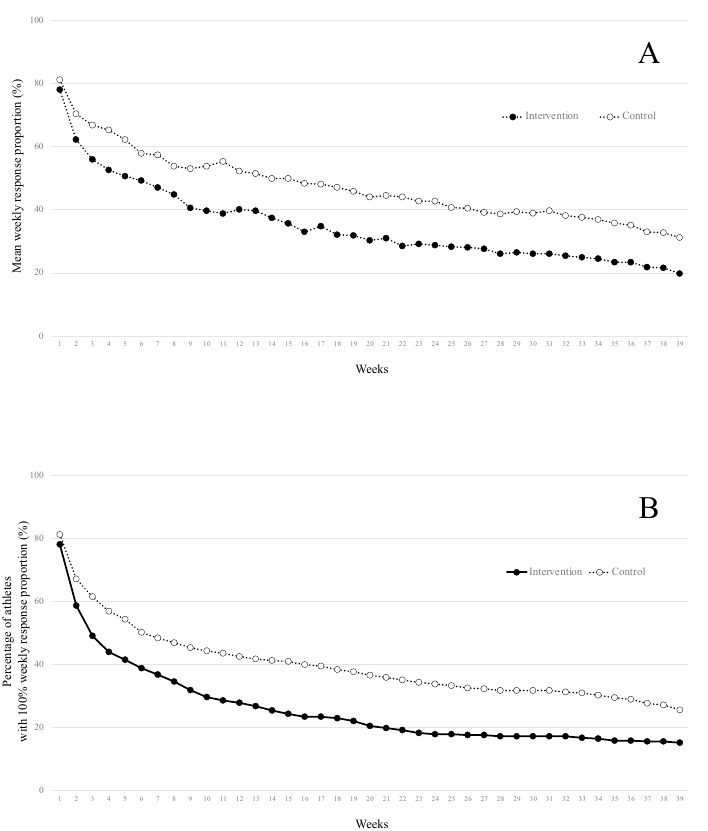
Figure 2. The evolution of ( A ) the mean weekly response proportions and ( B ) the percentage of athletes with 100% of response proportions in the intervention and the control groups over the 39 weeks of follow-up.